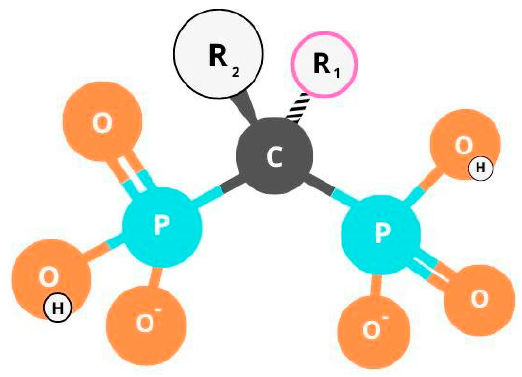
Figure 3. Chemical structure of BPs.